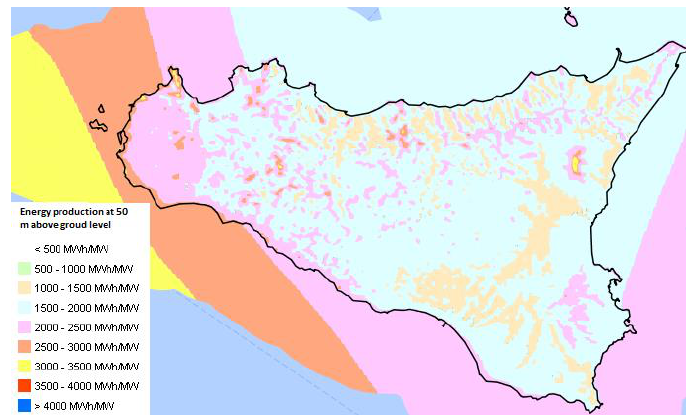
Figure 3. Energy production in Sicily at 50 m above ground level [21].